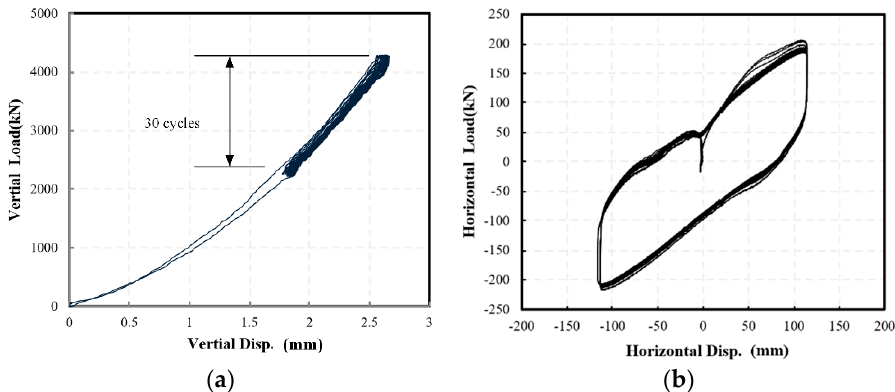
Figure 10. The force‑deformation curves of LRB‑600 specimens in the cyclic test in ( a ) vertical and ( b ) horizontal direction.